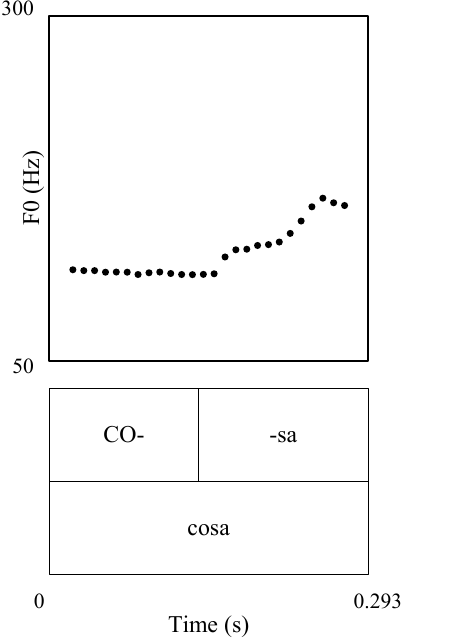
Figure 6. Restricted cosa ‘what’ produced by Gildo in Extract (8) with a falling contour